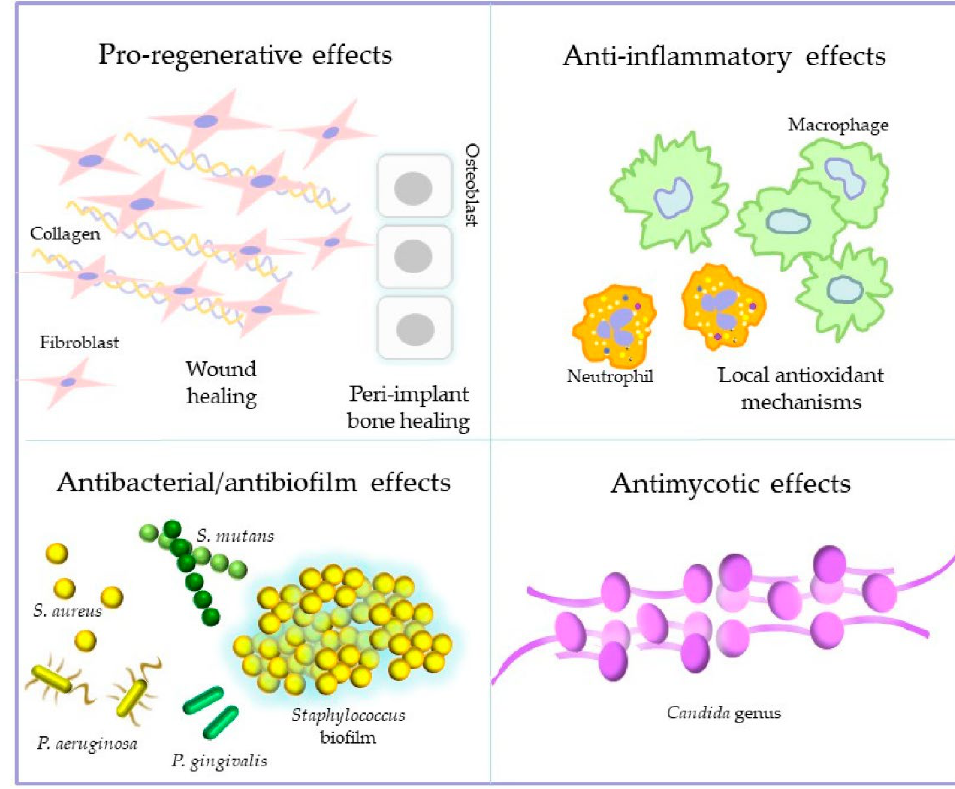
Figure 2. Principal biological effects reported for ozone treatments.